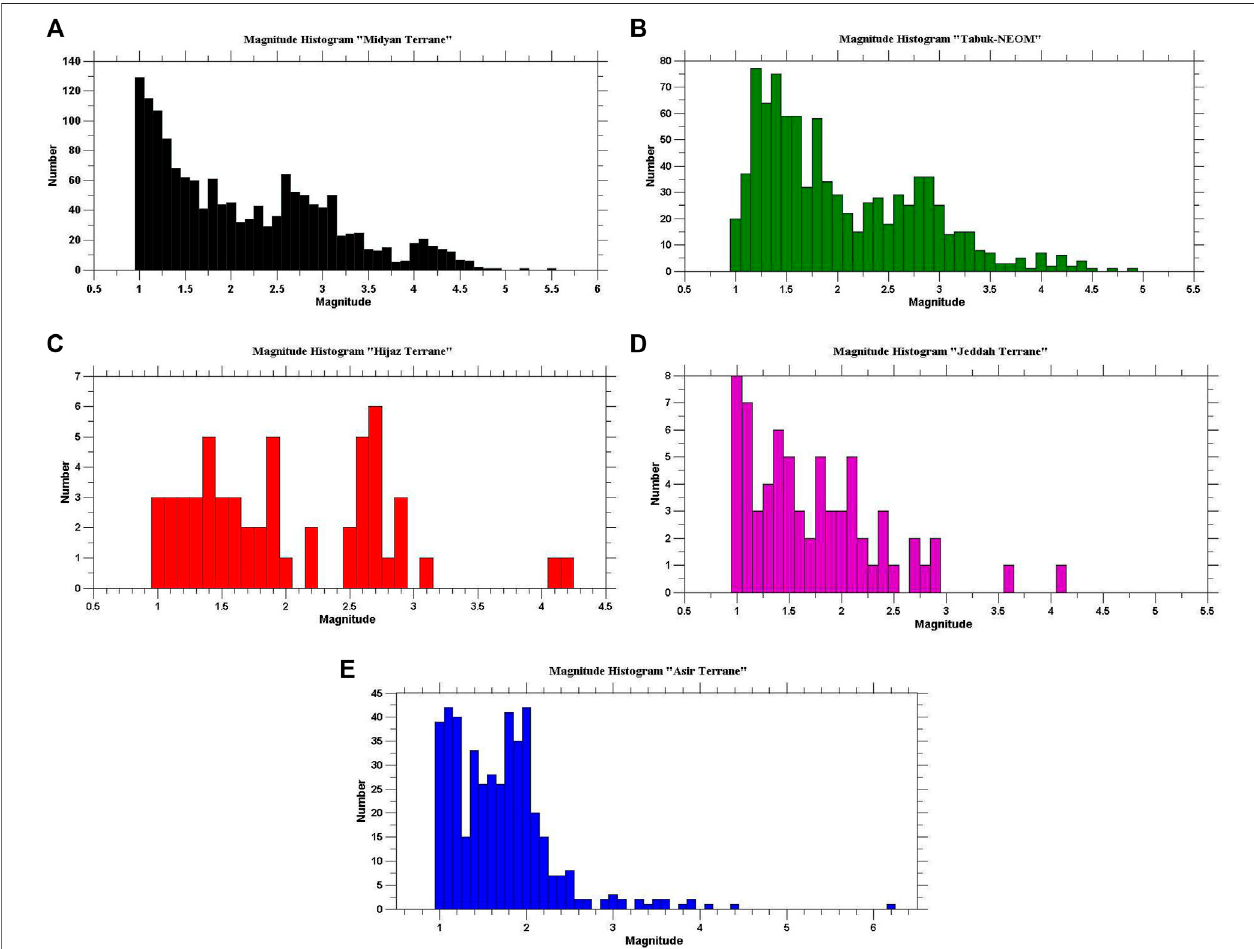
FIGURE 9 | (A – E) Magnitude histograms for the studied regions as represented by the color legend.